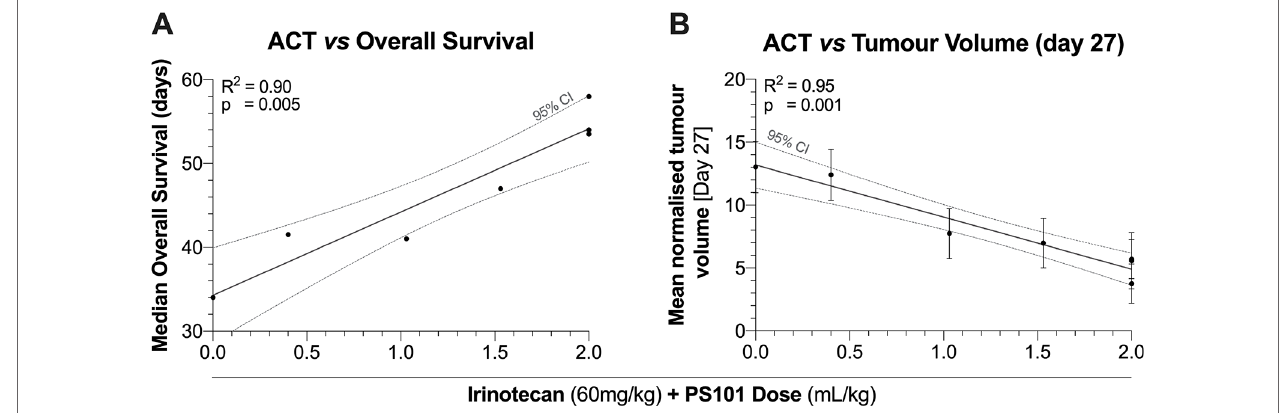
FIgURe 5 | Median overall survival (Panel A ) and tumour volume (Panel B ) as a function of the PS101 dose employed when ACT was used to enhance treatment with irinotecan. Increasing the PS101 dose was related to both an increased survival and a reduced tumour volume at day 27.